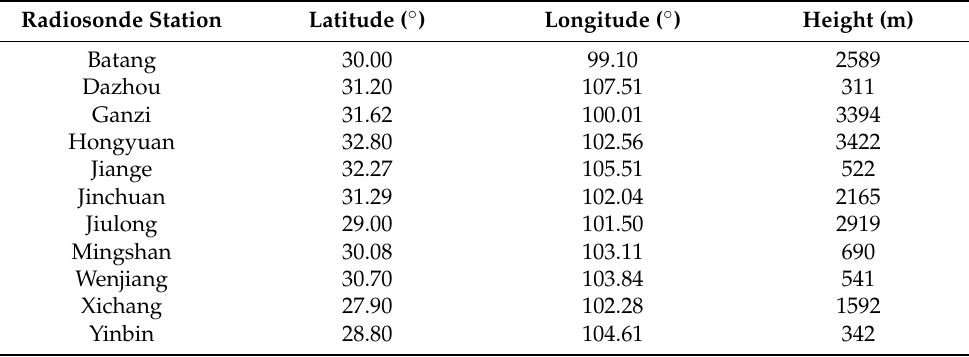
Figure 1. The topography and distribution of RAOB stations in the study region. Table 1. Radiosonde stations in the Southeastern Tibetan Plateau.